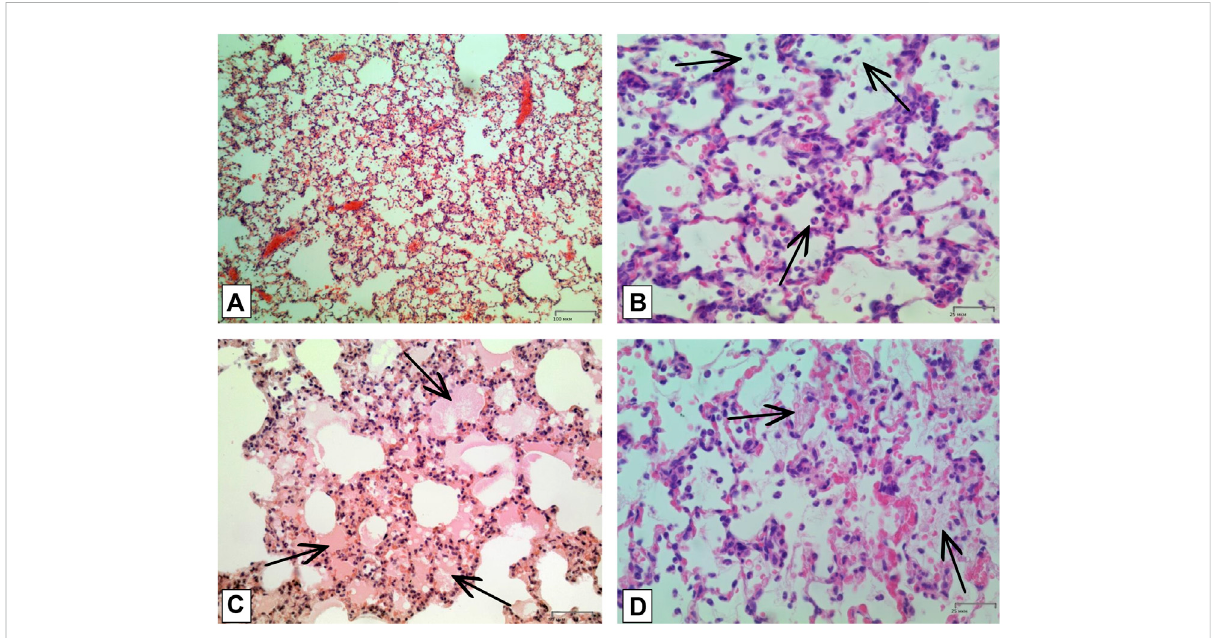
FIGURE 5 Histologic examinationof lungs tissue in4 hafter LPS + HVL applied. (A) Interstitialand intra-alveolar in fi ltratesbyleucocytesand erythrocytes. Magni fi cation y 100; (B) Intra-alveolar in fi ltrates by segmento-nuclear (segmented) neutrophils. Magni fi cation y 400; (C) Intra-alveolar edema.